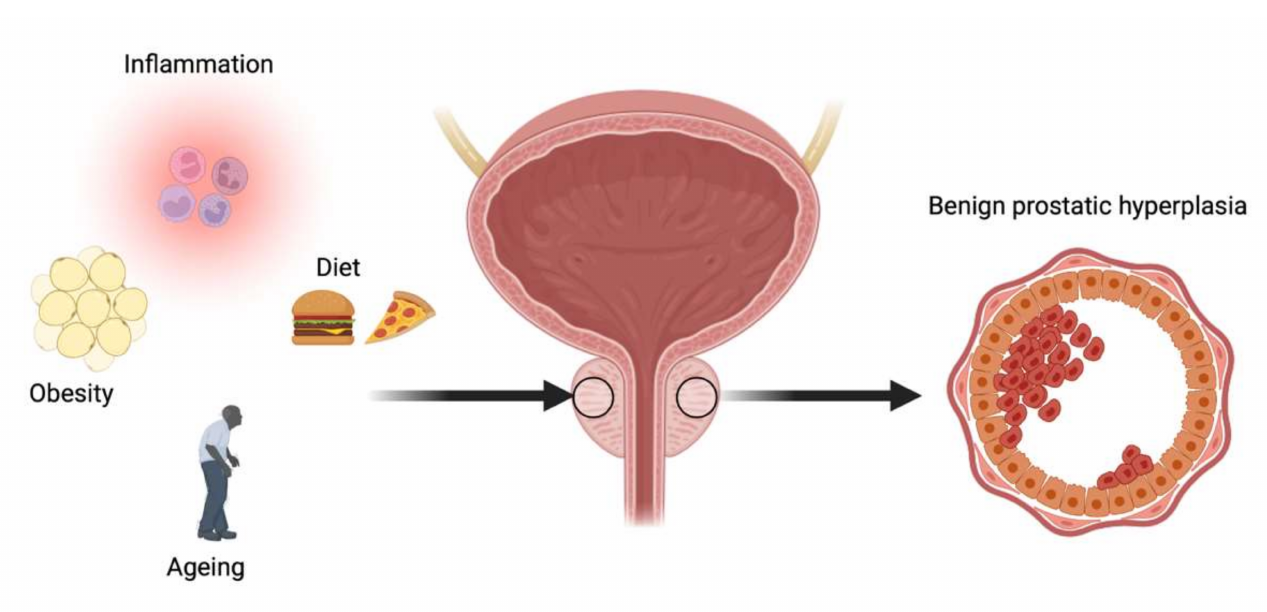
Figure 3. Overview of mechanisms associated with benign prostatic